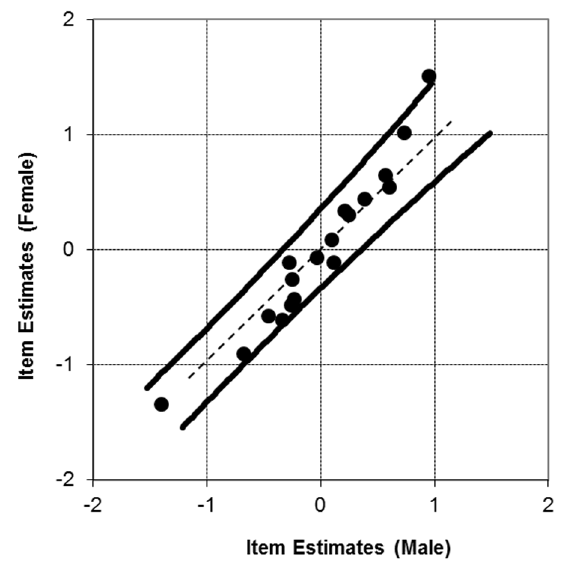
Figure 1. Scatter plot of item estimates from two separate calibrations (Male -